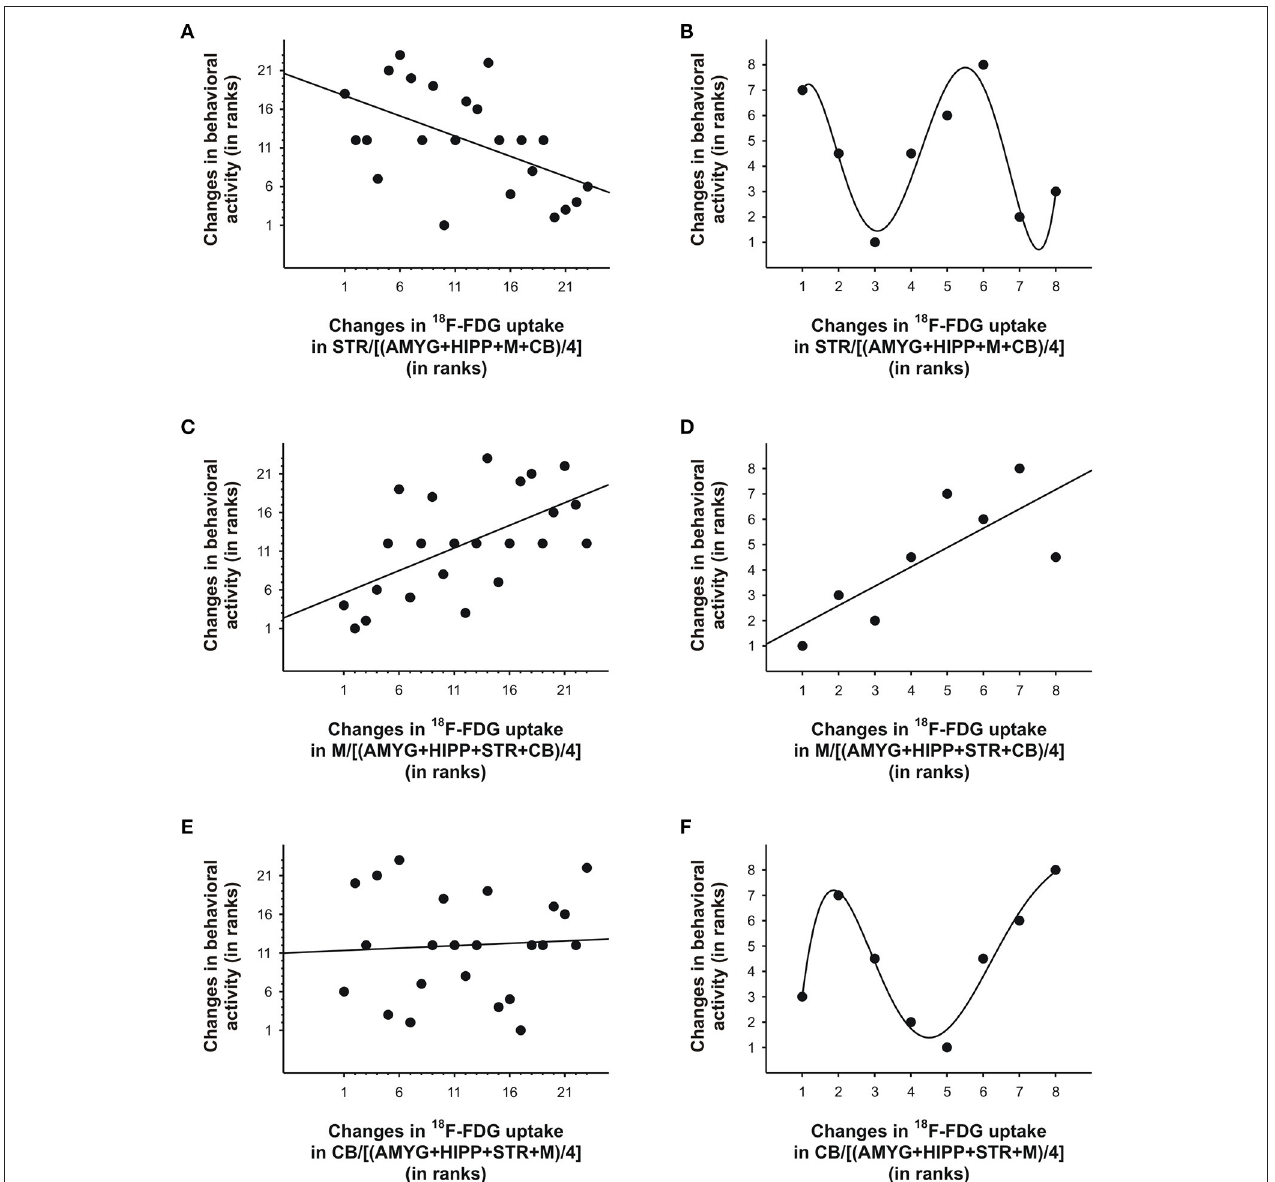
FIGURE 8 | Changes in 18 F-FDG uptake correlated with changes in behavioral activity across scan 2 in rat. We correlated changes in 18 F-FDG uptake, i.e., differences between successive 5min time bins, in the (A, B) striatum (STR), (C, D) motor cortex (M), and (E, F) cerebellum (CB) relative to a reference region (the average uptake in a combination of four ROIs) with changes in behavioral activity for the same time frames. When all 5min time frames ( n = 23) were included for analysis (A, C, E), changes in 18 F-FDG uptake in the STR and M, but not CB, significantly predicted changes in behavioral activity across time. When only the time frames ( n = 7-8) near the 18 F-FDG injections (B, D, F) were included for analyses, a linear function could be used to predict changes in behavioral activity from changes in uptake in M (D) , but polynomial functions provided the best fit for the data from STR (B) and CB (F) . For illustration, we fitted a quintic polynomial to the data (B, F) . The data are represented as ranks. Rank 1 indicates the largest decrease, whereas the highest rank indicates the largest increase between any of two successive 5-min-long time